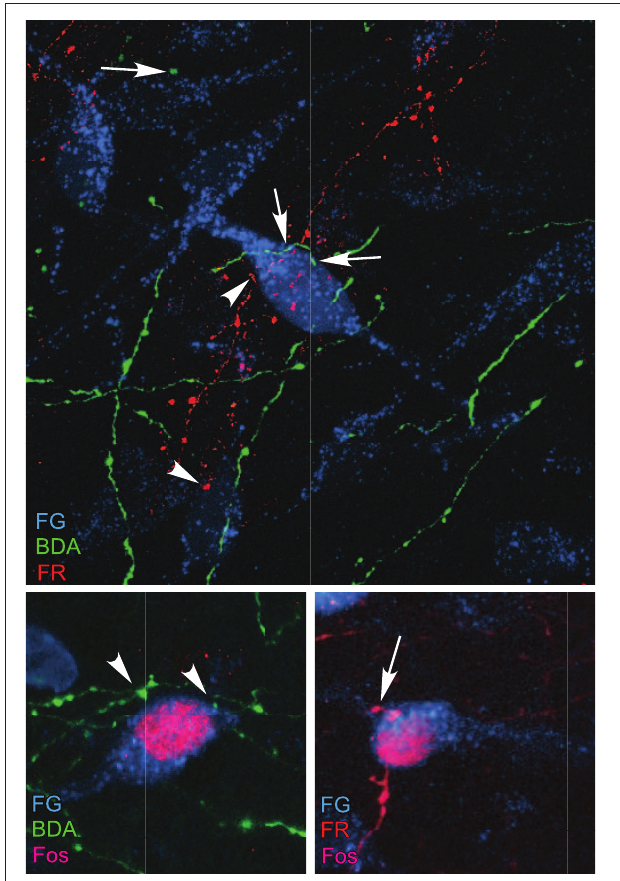
FIGURE 4 | Top: Overlap of retrograde tracer injections in PVH (Fluoro-gold, FG; cyan), and anterograde tracers in PL (BDA; green) and vSUB (FlouroRuby, FR; red) was evaluated in fluorescence preparations using confocal microscopy. Instances of BDA- (arrows) and FR-labeled (arrowhead) terminals were found to make appositions onto single PVH-projecting neurons in aBST, by analysis of single optical planes containing fluorescence labeling for all three markers. Bottom row: After a single stress exposure, numerous instances of Fos-labeled nuclei are evident in PVH-projecting neurons containing appositions from BDA- (left) and FR-labeled (right) terminals. Data are based upon Radley and Sawchenko (2011).